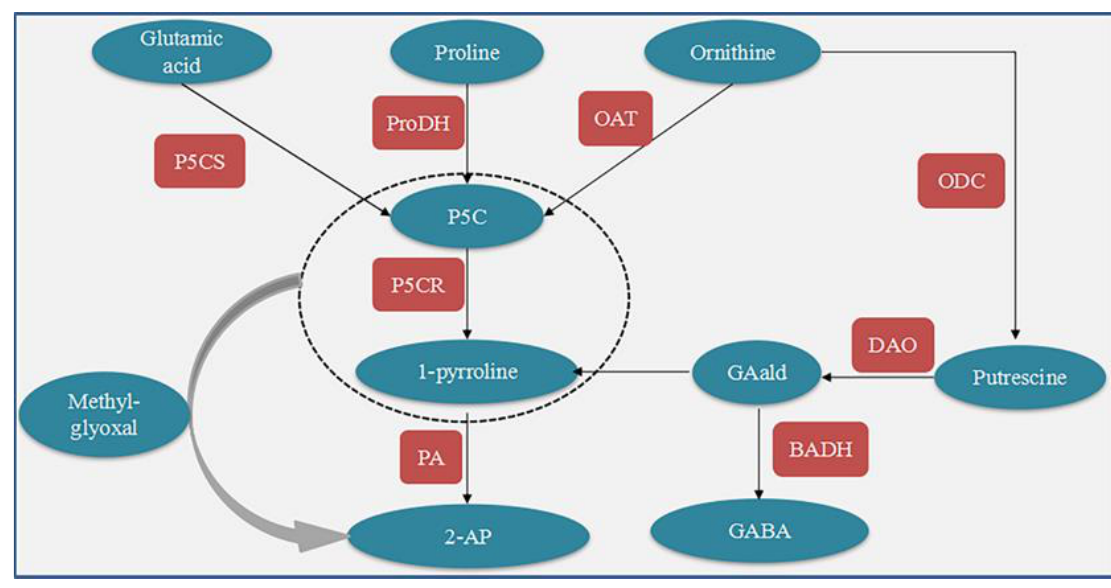
Figure 1. Possible pathway of 2-AP biosynthesis in aromatic rice . (P5CS: △ 1-pyrroline-5-carboxylic acid synthetase; ProDH: proline dehydrogenase; OAT: ornithine aminotransferase; P5C: pyrroline-5-carboxylic acid; P5CR: pyrroline-5-carboxylate reductase; ODC: ornithine decarboxylase; PA: pyrroline acetyltransferase; 2-AP: 2-acetyl-1-pyrroline; DAO: diamine oxidase; GAald: gamma-aminobutyraldehyde; BADH: betaine aldehyde dehydrogenase; GABA: gamma-aminobutyric acid.).